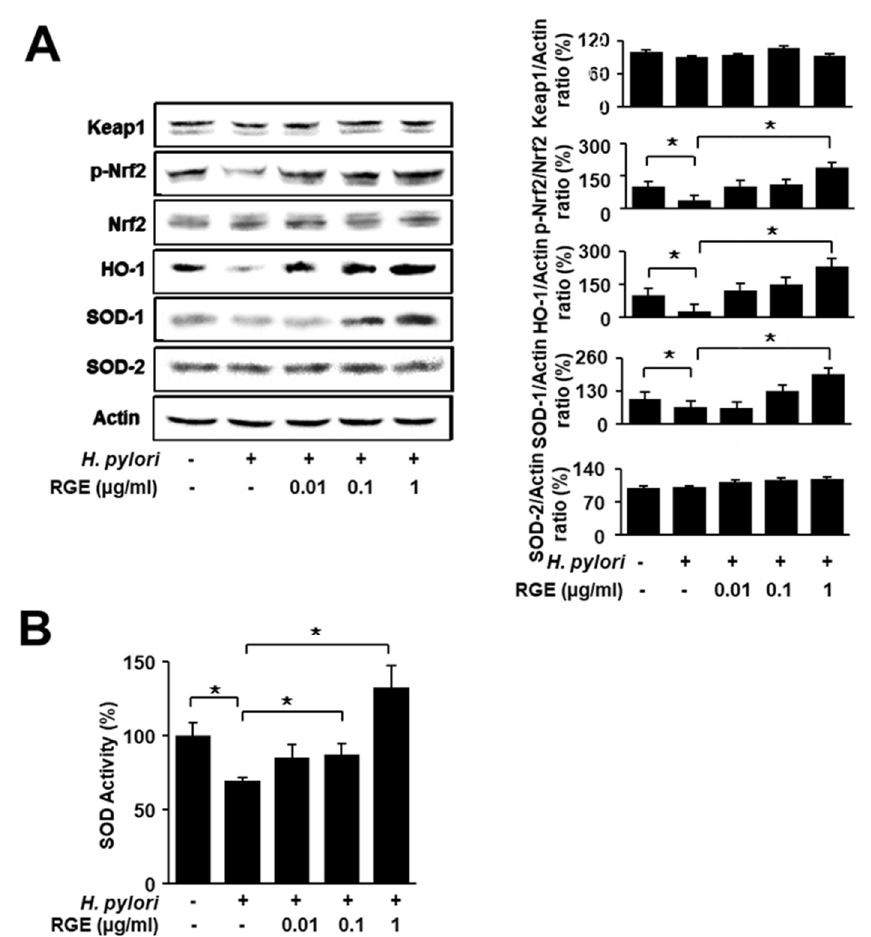
Figure 2. RGE suppresses reduction in phosphorylated Nrf2, HO-1, and SOD-1 levels and SOD activity in H. pylori -infected AGS cells. The cells were pretreated with the indicated concentrations of RGE for 1 h and then infected with H. pylori for 1 h. ( A ) The levels of Nrf2, phosphorylated Nrf2, Keap1, HO-1, SOD-1, and SOD-2 in whole-cell extracts were determined by western blotting (left panel). The ratios of Keap1/Actin, p-Nrf2/Nrf2, HO-1/Actin, SOD-1/Actin, and SOD-2/Actin were determined from band densities of these proteins. The protein band of the untreated and uninfected cells was set at 100. * p < 0.05 (right panel). The densitometry data represent the mean ± standard error (SE) from three immunoblots and are shown as the relative density of protein bands normalized to actin. ( B ) SOD activity in whole-cell extracts was measured using an SOD assay kit. The SOD activity in the untreated and uninfected cells was set at 100%. * p < 0.05.